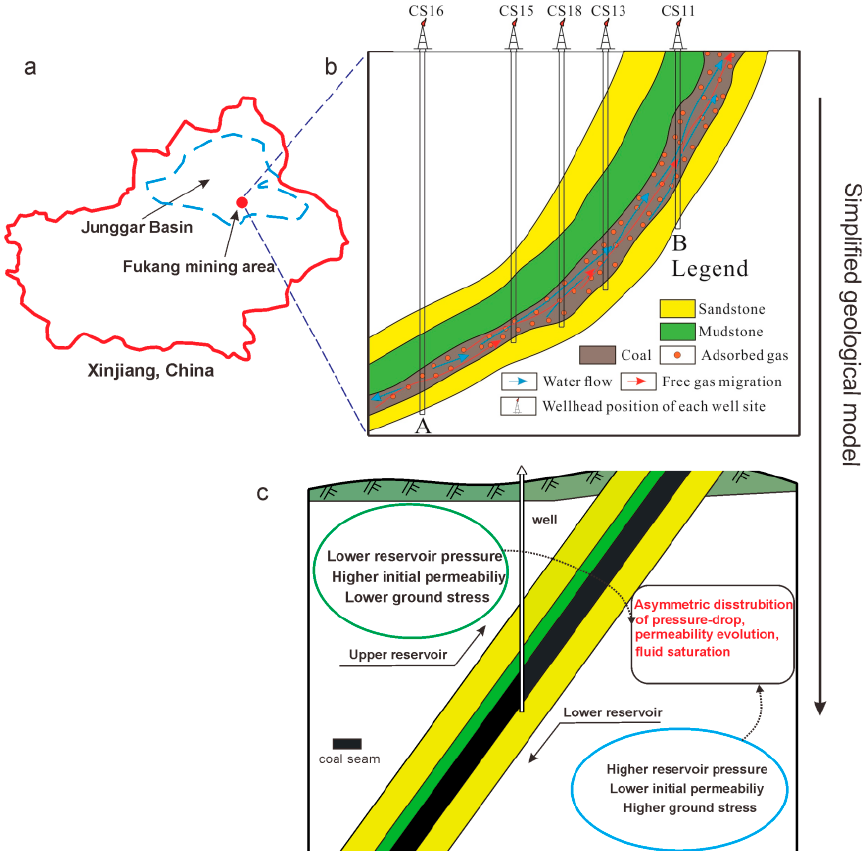
Figure 1. Characteristics of steeply-dipping coalbed methane (CBM) reservoirs, ( a ) location of the study area in China, ( b ) characteristics of the coal seams in the Badaowan Formation of the west Fukang Block [16], ( c ) a simplified geological model of a steeply-dipping CBM reservoir.